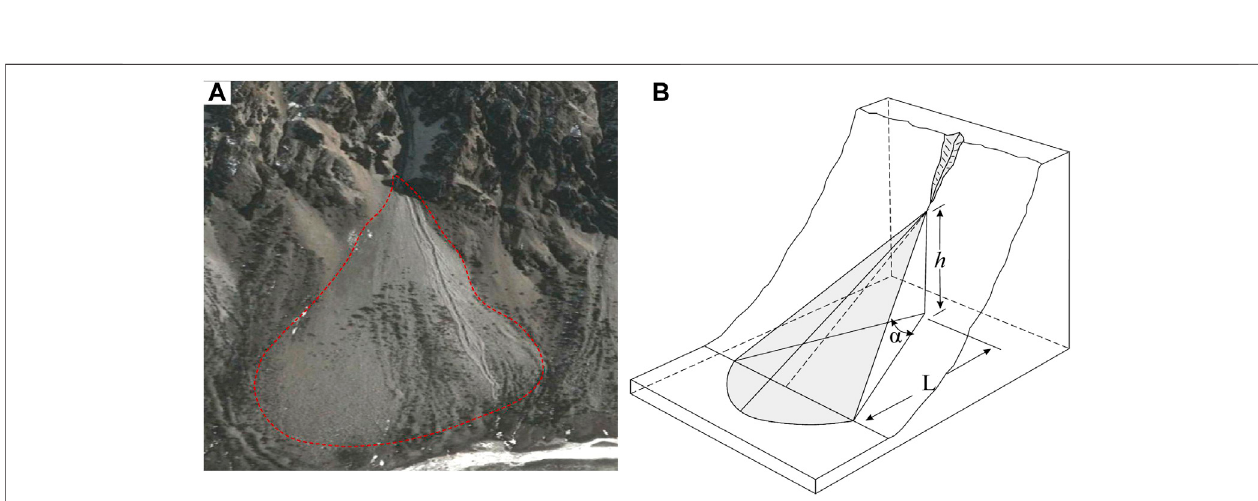
FIGURE 6 | The accumulation morphology and geometric model of debris aprons. (A) Field image. (B) Corresponding sketch model.